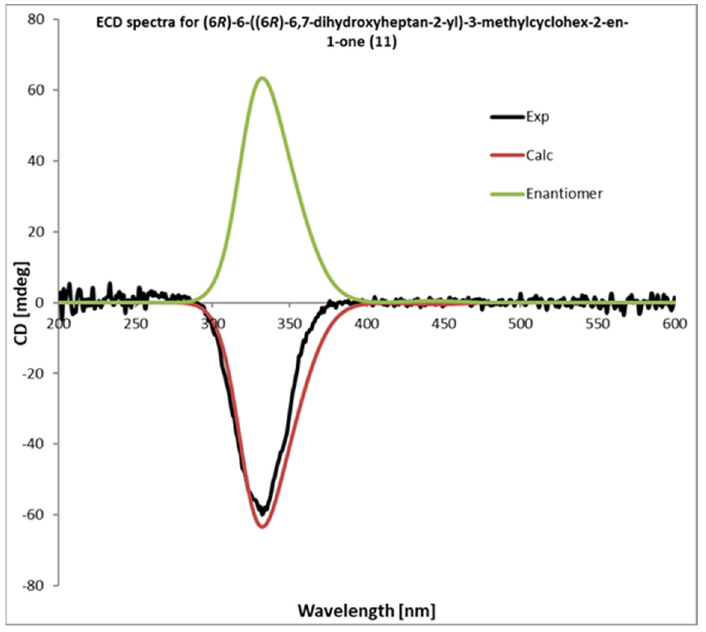
(6 R )-6-((6 R )-6,7-dihydroxyheptan-2-yl)-3-methylcyclohex-2-en-1-one (Figure 7).